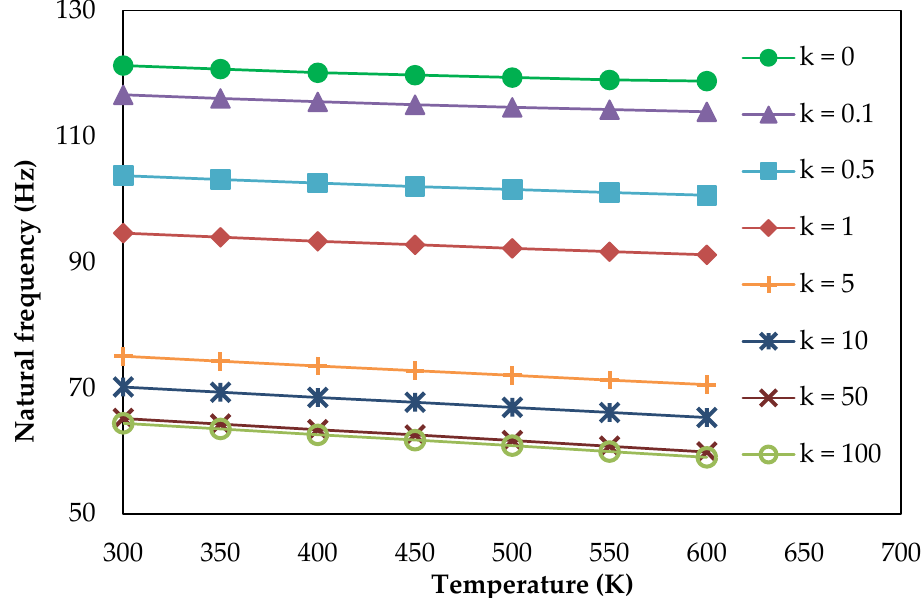
Figure 10. Variation of the natural frequency of a Ti-6Al-4V/aluminum oxide FGM shell in uniform thermal field for different material composition for re-entry vehicle nose structures.